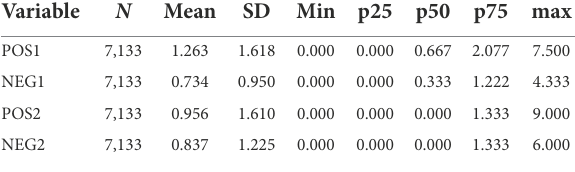
TABLE 7 The impact of the COVID-19 epidemic and management tone descriptive statistics.